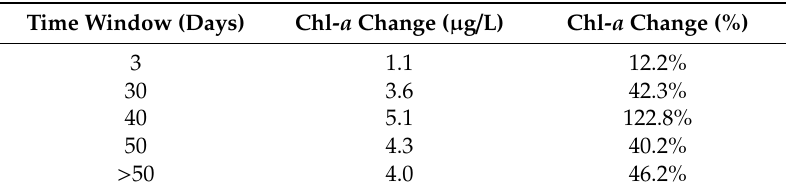
Table 5. Chl- a change in di ff erent time